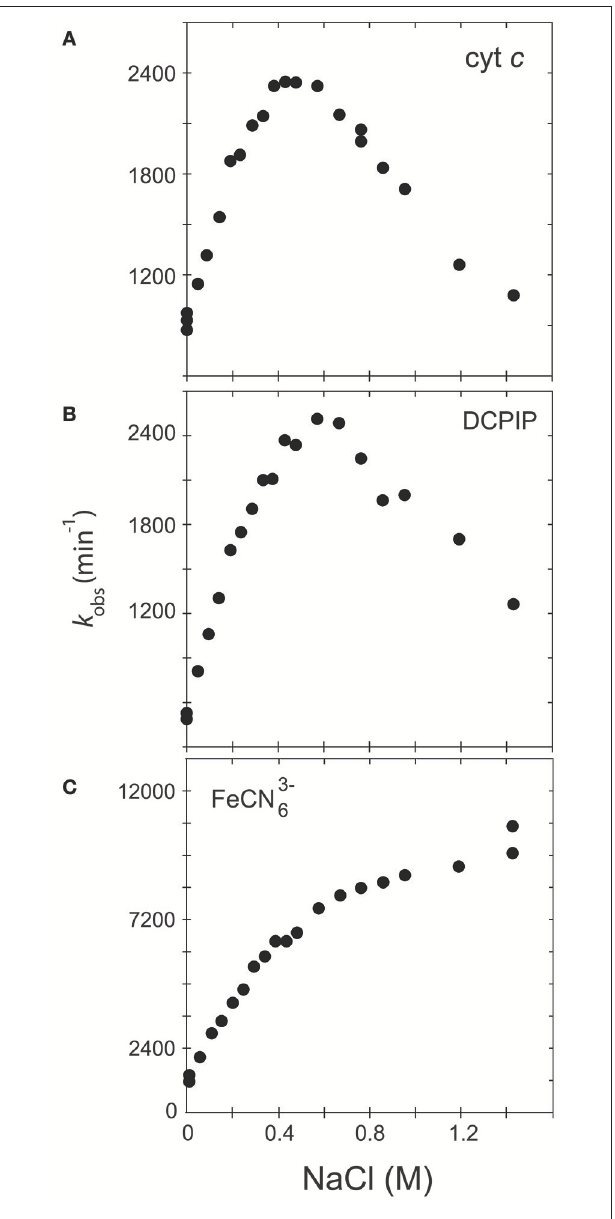
FIGURE 1 | Variation of k obs in function of the ionic strength. The activity of the soluble, WT form of human CPR was assayed with various acceptors, namely cytochrome c (A) , DCPIP (B) or ferricyanide (C)